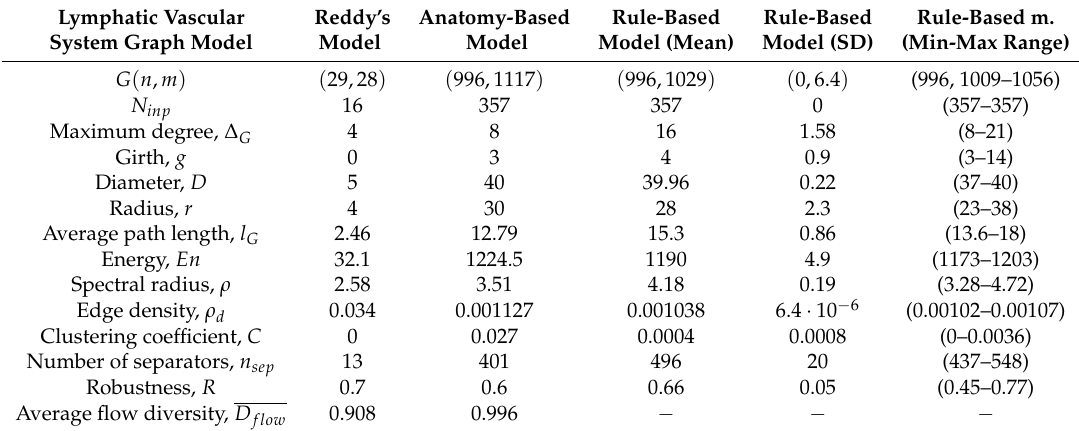
Table 1. Summary statistics for Reddy’s, anatomy-based and rule-based graphs characterizing their topological properties. For algorithmically generated graphs, we present the statistics obtained over 10,000 graphs generated with algorithm parameters P e = 0.035, P o = 0.21, N l = 41. Robustness was calculated over 1000 algorithm realizations, with 1000 removal attempts for each graph.